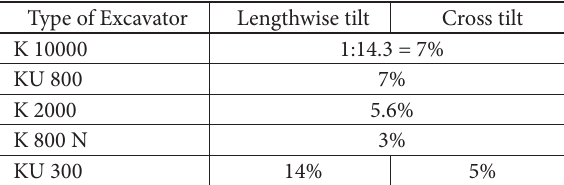
Table 2. Geometric parameters Type of Excavator Lengthwise tilt Cross tilt